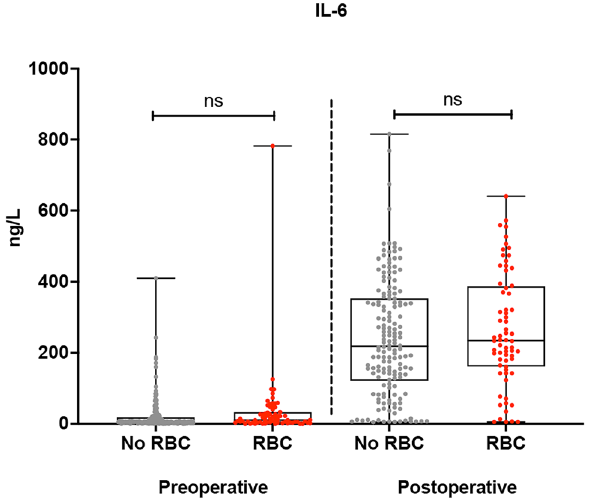
Figure 2. Pre- and postoperative interleukine-6 (IL-6) cytokine levels (ng/L) in with and without red blood cell transfusion (RBC) after adult cardiac surgery. The vertical axis represents IL-6 levels (ng/L). The horizontal axis represents patients who received or not RBC transfusion preoperatively and postoperatively.